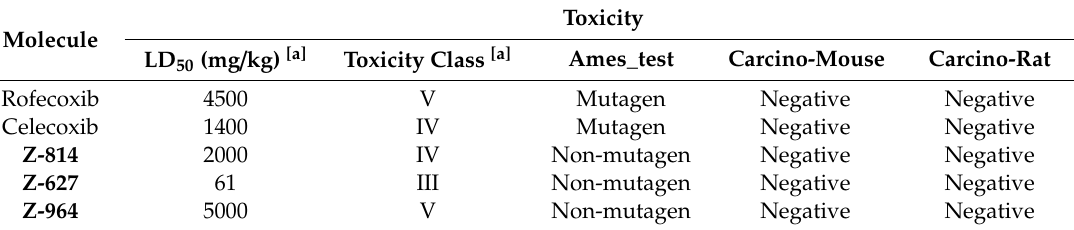
Table 7. Toxicological data of selected inhibitors.